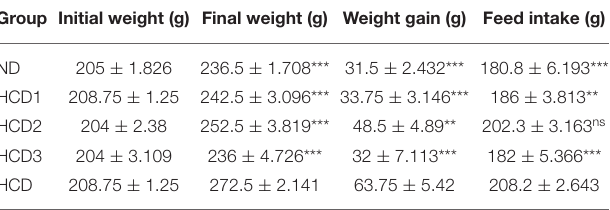
67.8 ± 0.527, 64.2 ± 4.13, and 77.6 ± 4.35 mg/dl for the ND, HCD1, HCD2, HCD3, and HCD dietary groups,